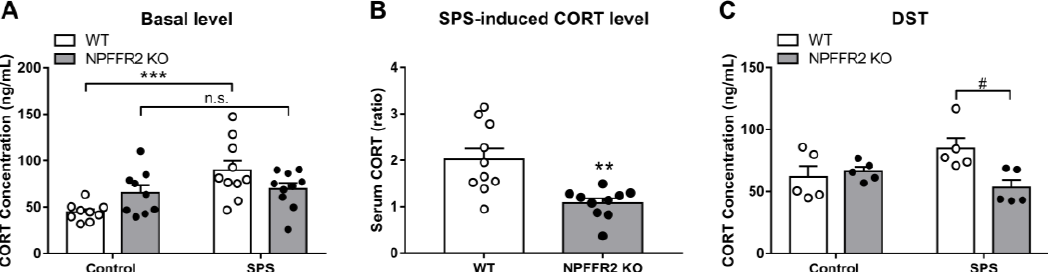
Figure 4. HPA axis function in WT and NPFFR2 KO mice after exposure to SPS. ( A ) The level of serum corticosterone (CORT) (WT-control, n = 9; WT-SPS, n = 10; NPFFR2-KO control, n = 10; NPFFR2 KO-SPS, n = 10). ( B ) The increase of serum CORT after mice were exposed to SPS ( n = 10 per group). ( C ) Negative feedback on the HPA axis was tested with the dexamethasone suppression test (DST) ( n = 5 per group). Data are represented as mean ± SEM. In Figure 4A and 4C, data are analyzed by two-way ANOVA with Bonferroni’s multiple comparison test. *** p < 0.001, n.s., no significance; comparing control and SPS groups; # p < 0.05, comparing WT and NPFFR2 KO mice. In Figure 4B, data are analyzed by unpaired Student’s t -test. ** p < 0.01, comparing WT and NPFFR2 KO mice. The white and black dots indicate the individual value of WT and NPFFR2 KO mice, respectively.